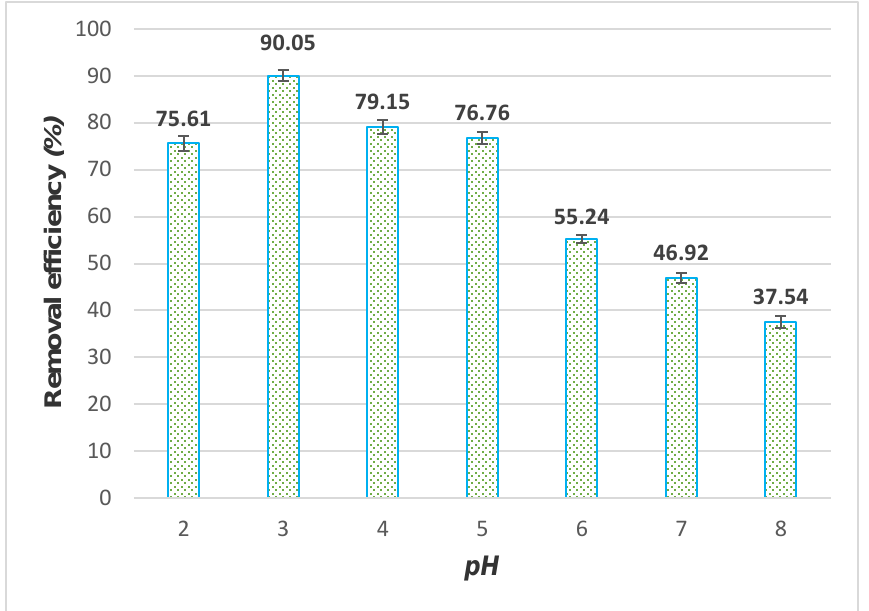
Figure 6. Effect of pH on the phenol removal performance of Fe-Cu material.